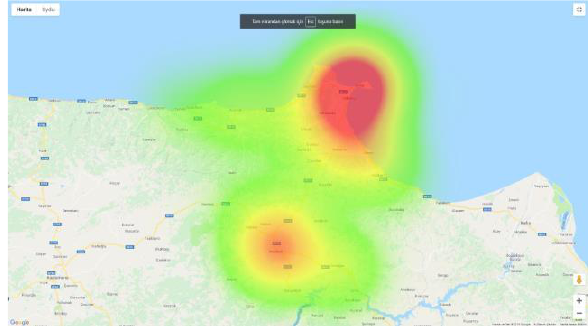
Figure 5. Displaying the actual accident data on the heat map.